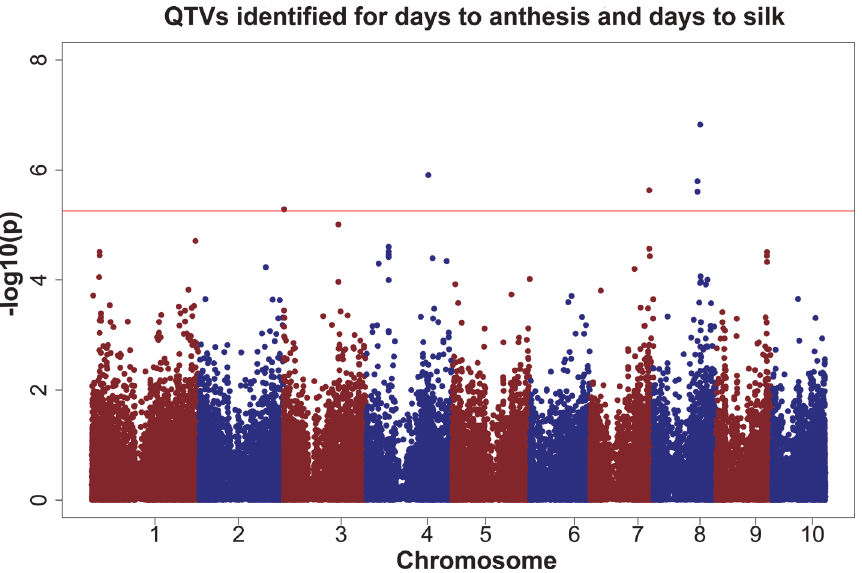
Fig 6. GWAS results for days to anthesis and days to silk. The phenotypic observation was the BLUPs for the CS12-WW trial. The red line represents the threshold value after correcting for multiple testing using the M eff or